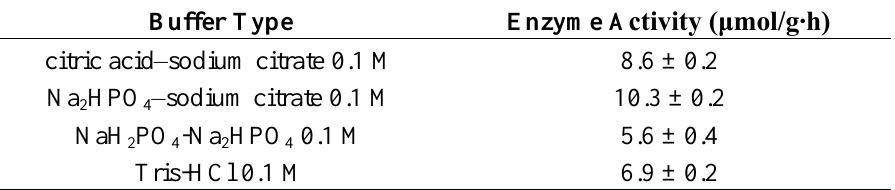
Table 2. Effect of buffer type on the activity of immobilized TVL.